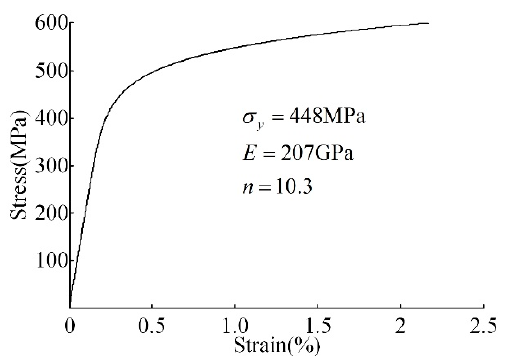
Figure 8. Relation between stress and strain of the X65 material.